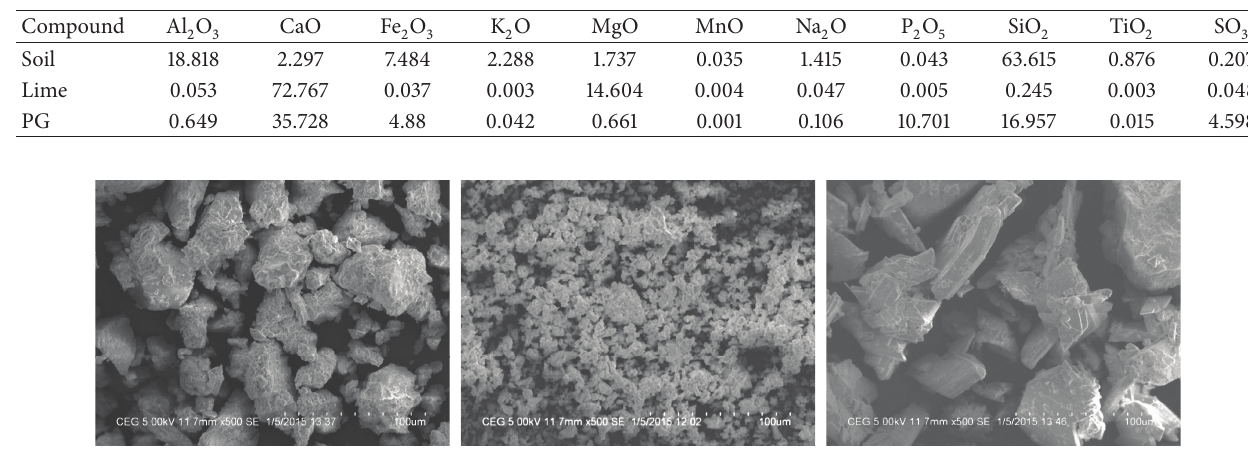
Table 2: Chemical composition of materials.